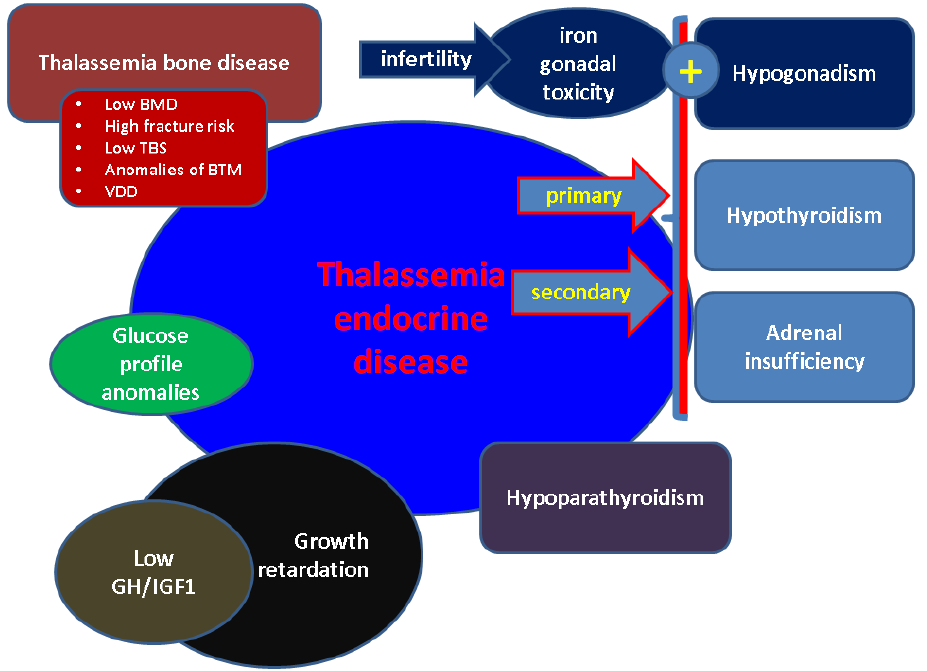
Figure 1. Overview of thalassemia endocrine disease (see references in text). Abbreviations: BMD = Bone Mineral Density, TBS = Trabecular Bone Score; BTM = Bone Turnover Markers, VDD = vitamin D deficiency; GH = Growth Hormone; IGF1 = Insulin ‐ like Growth Factor.